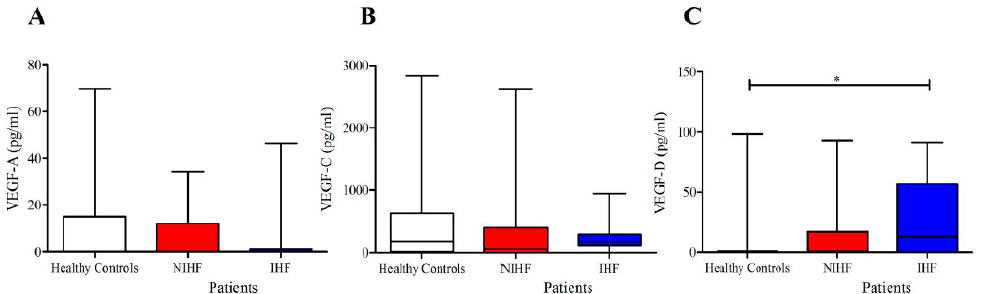
Figure 5. ( A ) Plasma concentrations of VEGF-A in IHF and NIHF patients and in healthy controls; ( B ) plasma concentrations of VEGF-C in IHF and NIHF patients and in healthy controls; ( C ) plasma concentrations of VEGF-D in IHF and NIHF patients and in healthy controls. Data are shown as the median (horizontal block line), the 25th and 75th percentiles (boxes), and the 5th and 95th percentiles (whiskers) (statistical analysis was performed by one-way ANOVA and Bonferroni’s multiple comparison test). * p < 0.05